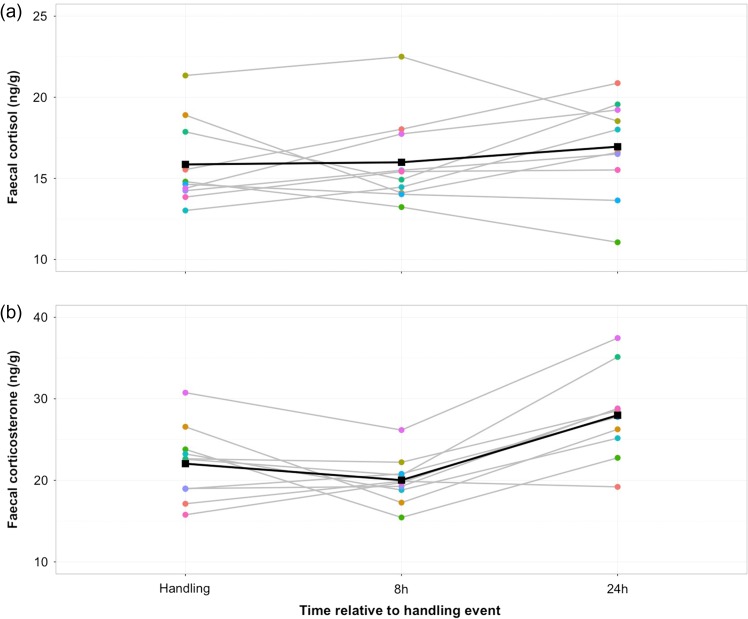
There was no significant increase in cortisol levels 8 or 24 h after handling (a), but there was a significant increase in corticosterone levels 24 h after handling (b). Faecal cortisol and corticosterone levels for individual animals are represented by different coloured circles connected by grey lines. Means are shown as black squares connected by black lines.